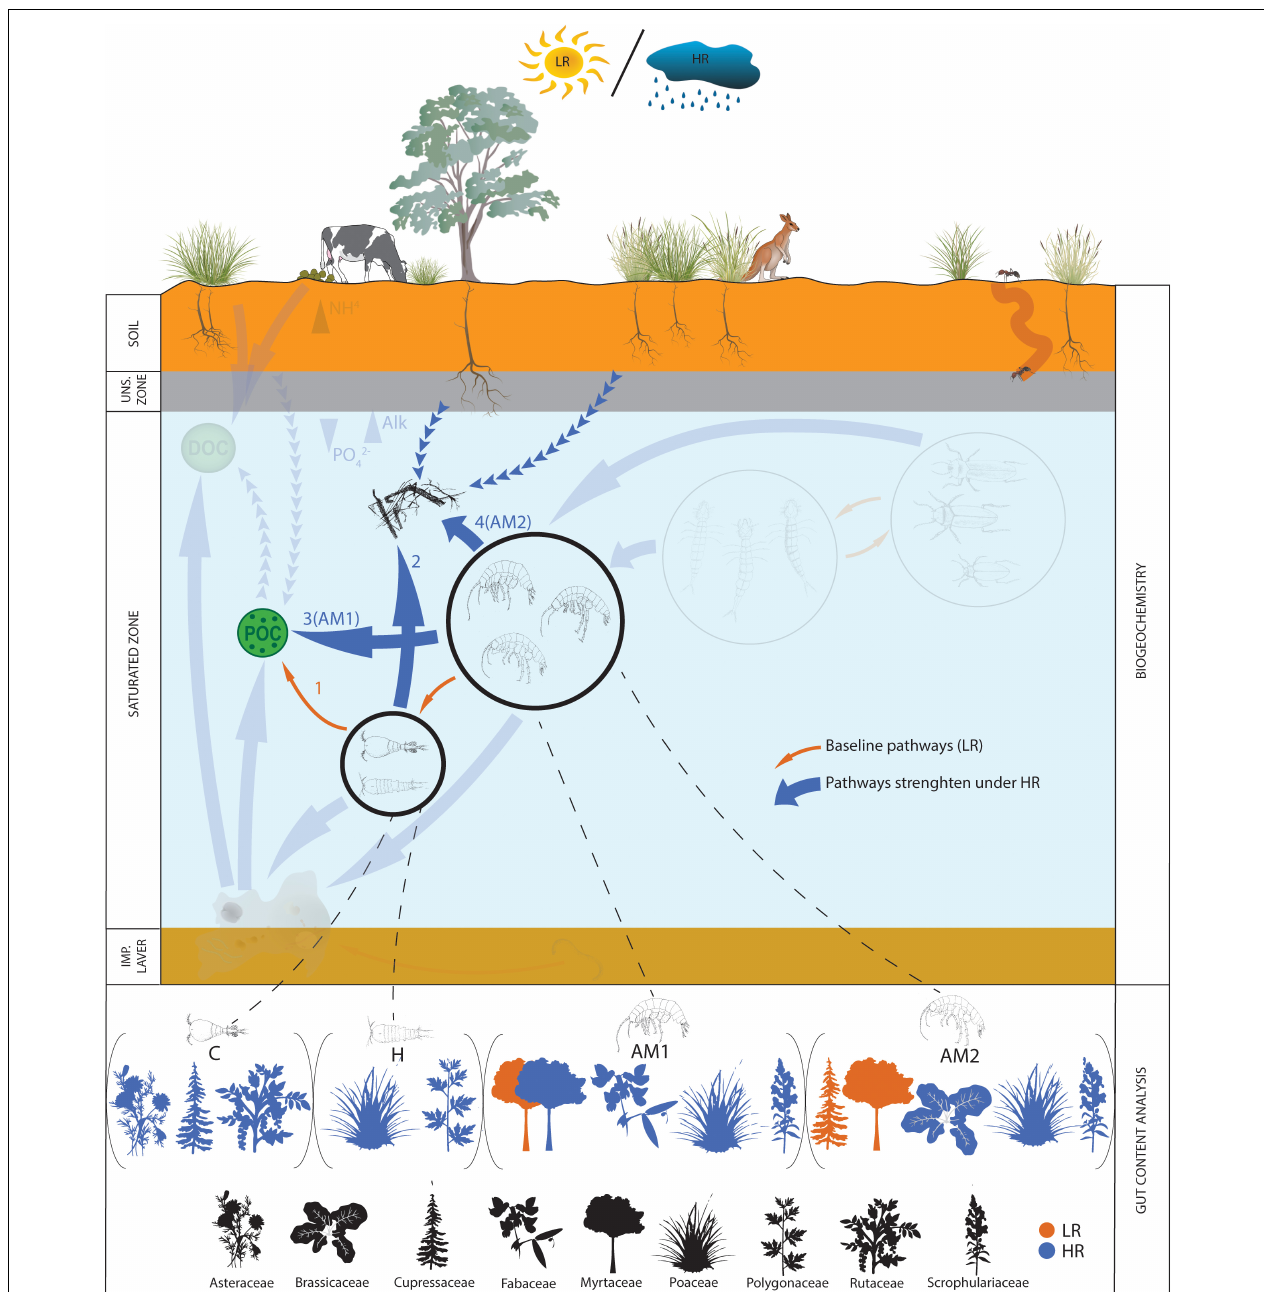
FIGURE 3 | Updated conceptual model from Saccò et al. (2021a), with incorporation of information on the plant-derived consumption of primary (C and H) and secondary consumers (AM1 and AM2). The orange arrows illustrate the baseline biochemical paths which were frequent during LR, while bigger blue arrows underline those transitions strengthened under HR. Transparent figures and arrows refer to dynamics already described in Saccò et al. (2021a). The key biochemical findings are numbered as follow: (1) POC provides the main potential plant-derived organic input in copepods’ diets under LR; (2) under HR, copepods shift toward a diet dominated by roots and associated microbiota; (3) amphipods AM1 increase POC incorporations ( ∼ two-fold) during HR, while (4) amphipods AM2 increase the proportion of their root-based diets after rainfall (HR). Dashed lines lead to the characterisation (presence of plant families in C, H, AM1 and AM2 under LR and HR) of the plant-derived material identified in stygofaunal guts via DNA metabarcoding